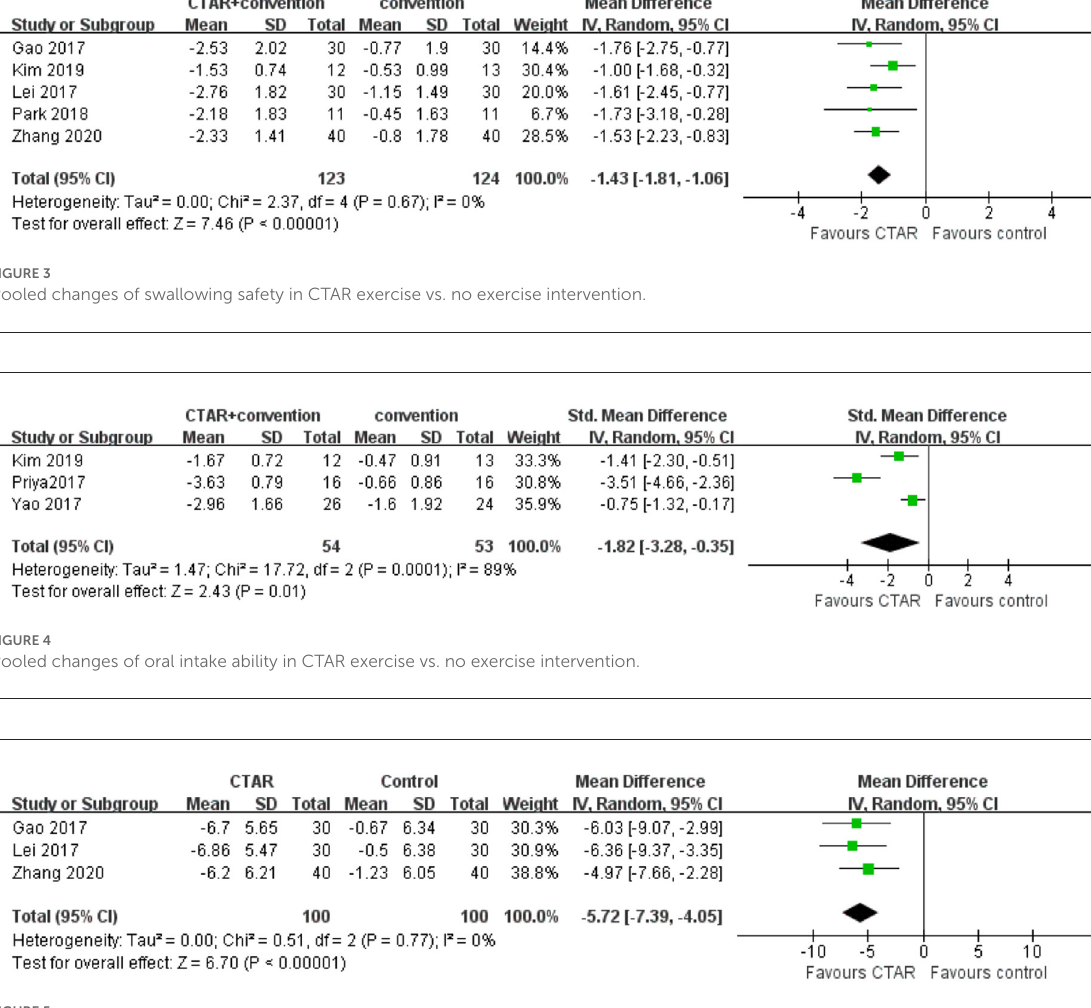
FIGURE5 Pooled changes of psychological condition in CTAR exercise vs. no exercise intervention.